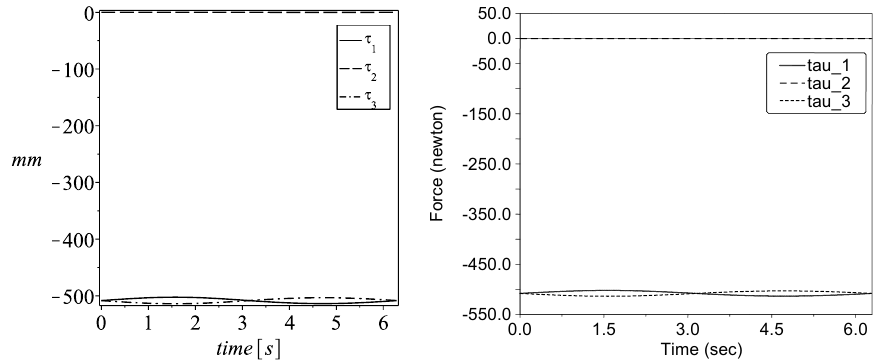
Figure 11. Diving forces. Using screw theory ( left ); and simulations in ADAMS ( right